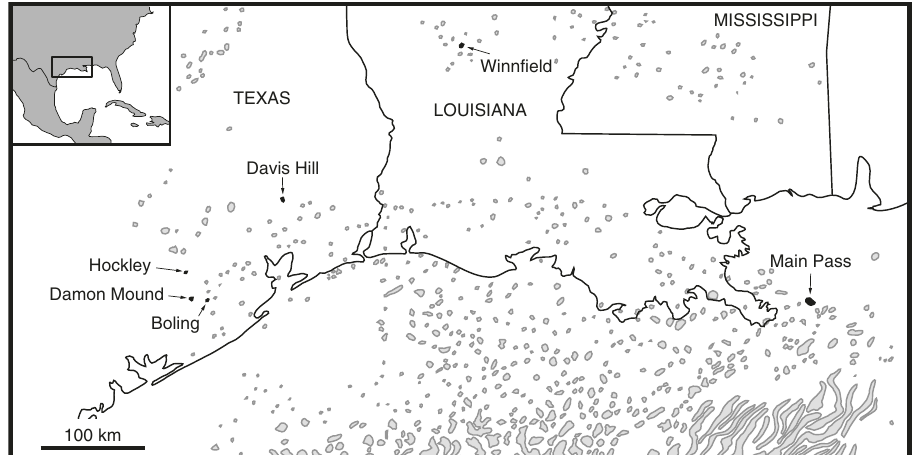
Fig. 1 Distribution of northern Gulf of Mexico Basin salt structures. Salt domes studied here are highlighted in black. Map modi fi ed from Martin 71 . AAPG©1978 reprinted by permission of the AAPG whose permission is required for further